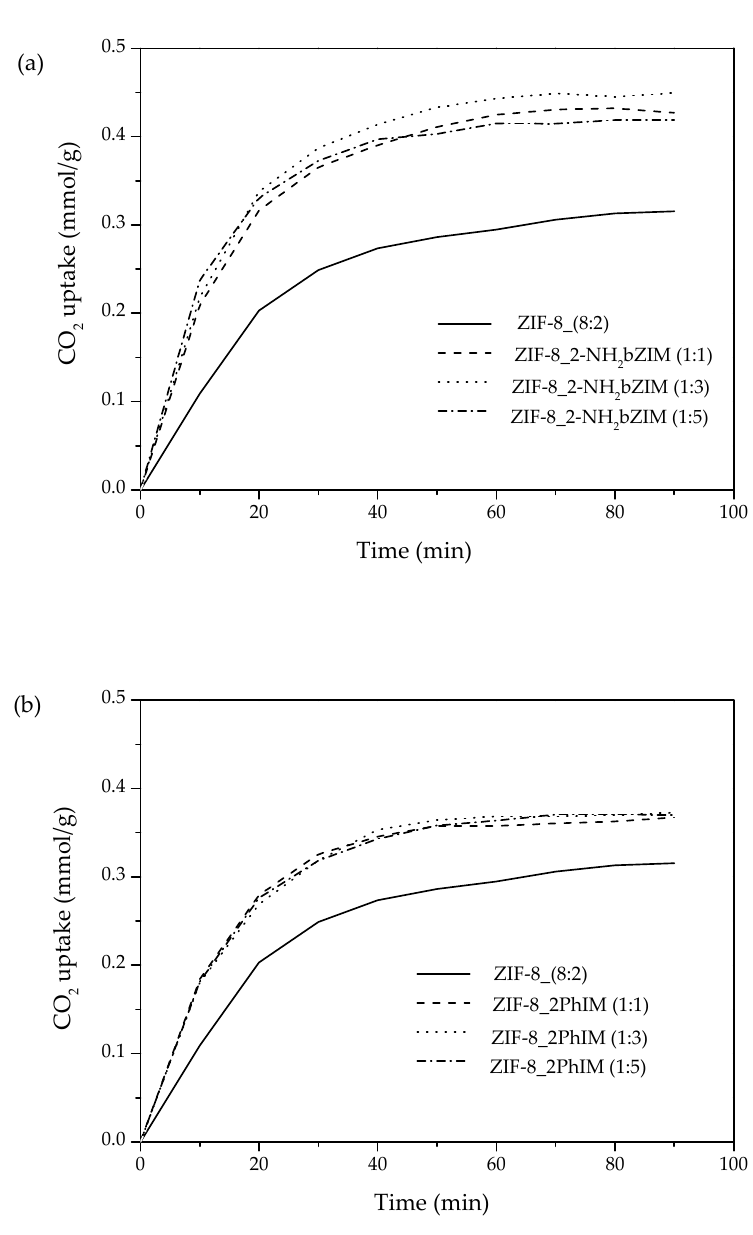
Figure 15. CO 2 uptake of synthesized ZIF-8 modified by ( a ) 2-aminobenzimidazole and ( b ) 2- phenylimidazole with different ratios between ZIF-8 and exchanged imidazole at 313 K.